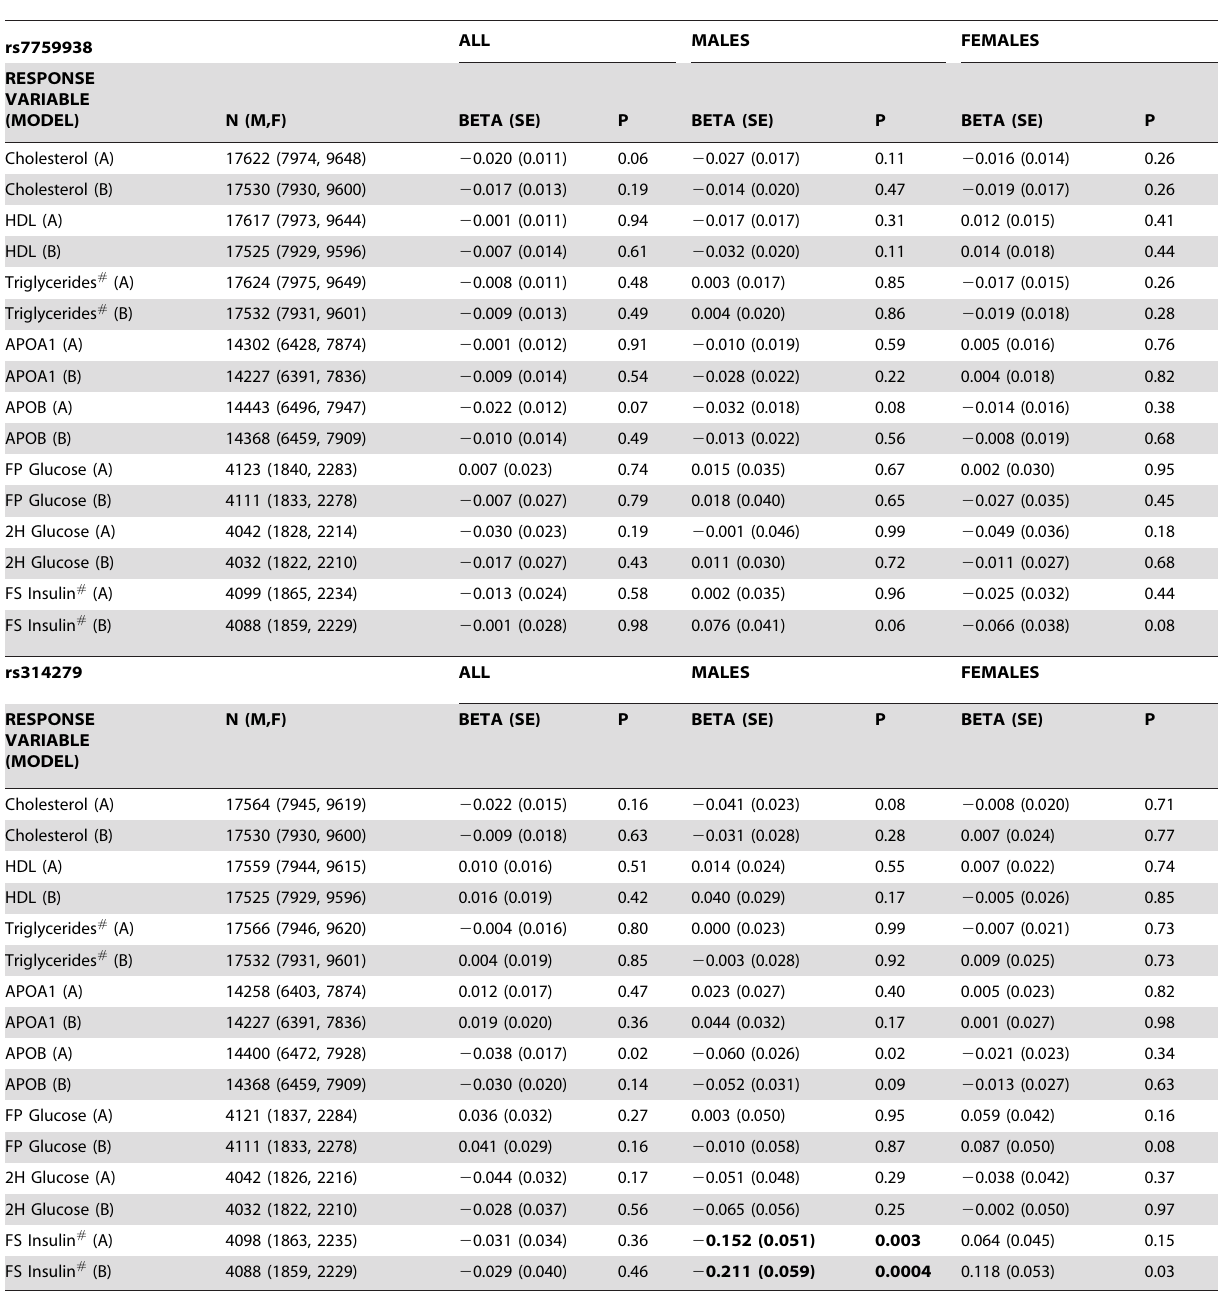
Table 2. Association of genetic variants rs7759938 (upper panel) and rs314279 (lower panel) with adult metabolic profiles.